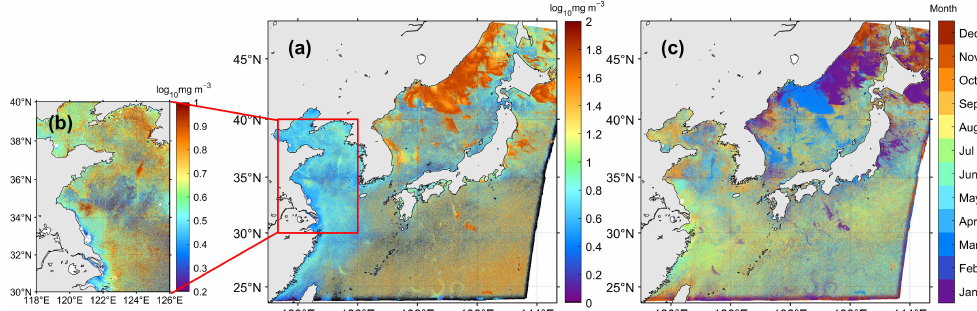
Figure 5. ( a ) Maximum chlorophyll- a (chl- a ) concentration in 2015, ( b ) enlarged area of red box in ( a ), and ( c ) distribution of month with the yearly maximum chl- a concentration.